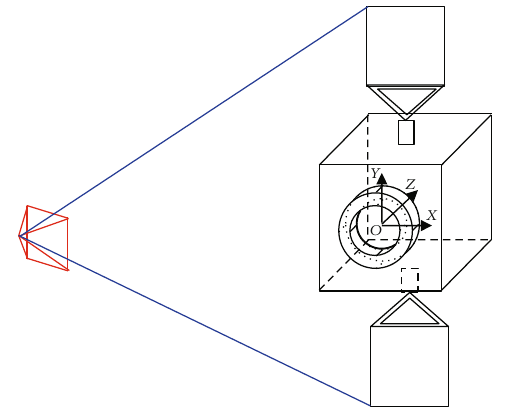
Figure 12: Schematic diagram of relative position relationship between the satellite model and the monocular camera.